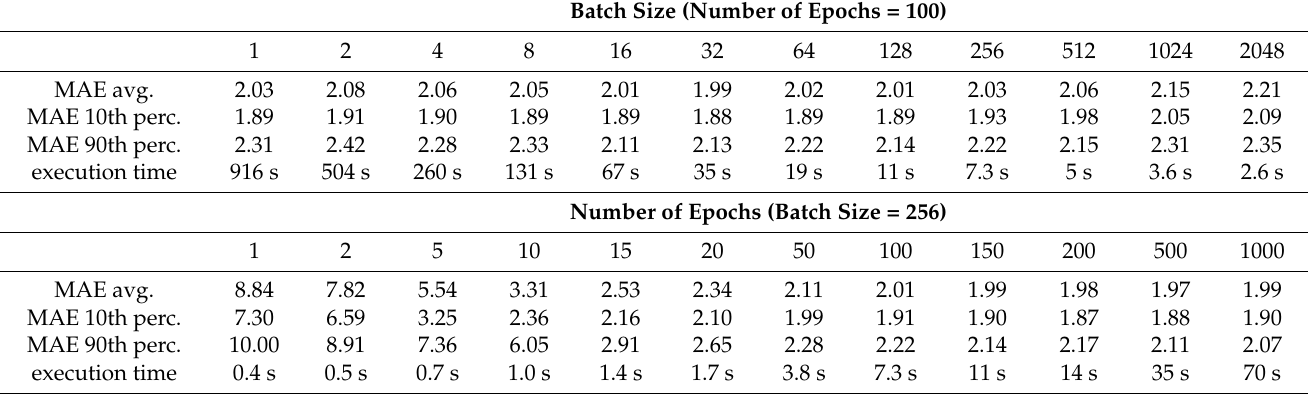
Table 4. Influence of batch size and number of epochs on the performance of the NN in setup Y. The MAE values are expressed in ◦ C. The execution time represents the time it took to train a single NN on a computer using a Nvidia GeForce RTX 3090